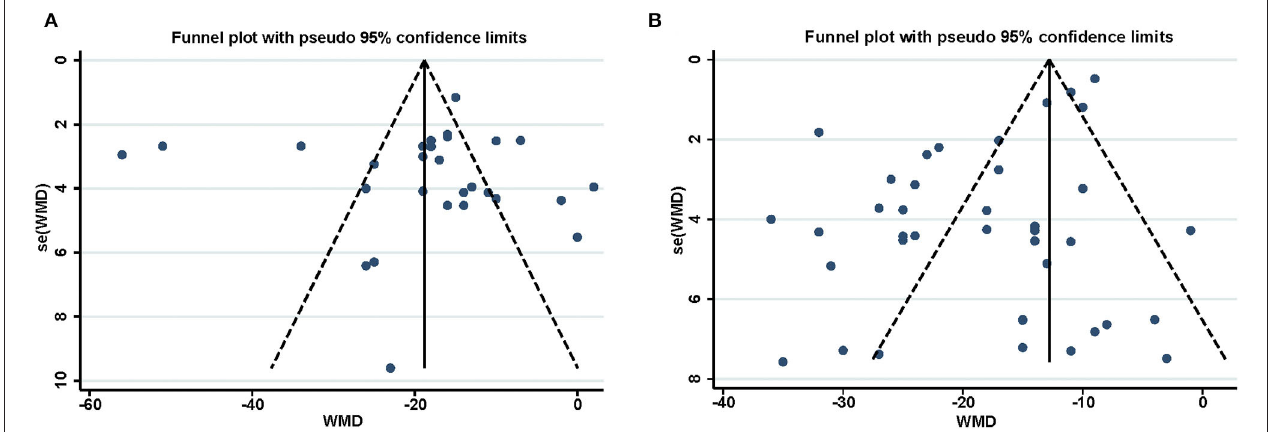
FIGURE 5 | Funnel plot for assessment of publication bias for the infarct size in SPreC (A) and SPostC (B) . The vertical line represents the mean effect size. The plots were assessed visually, with further analysis of publication bias performed using the Egger’s and Begg’s tests.